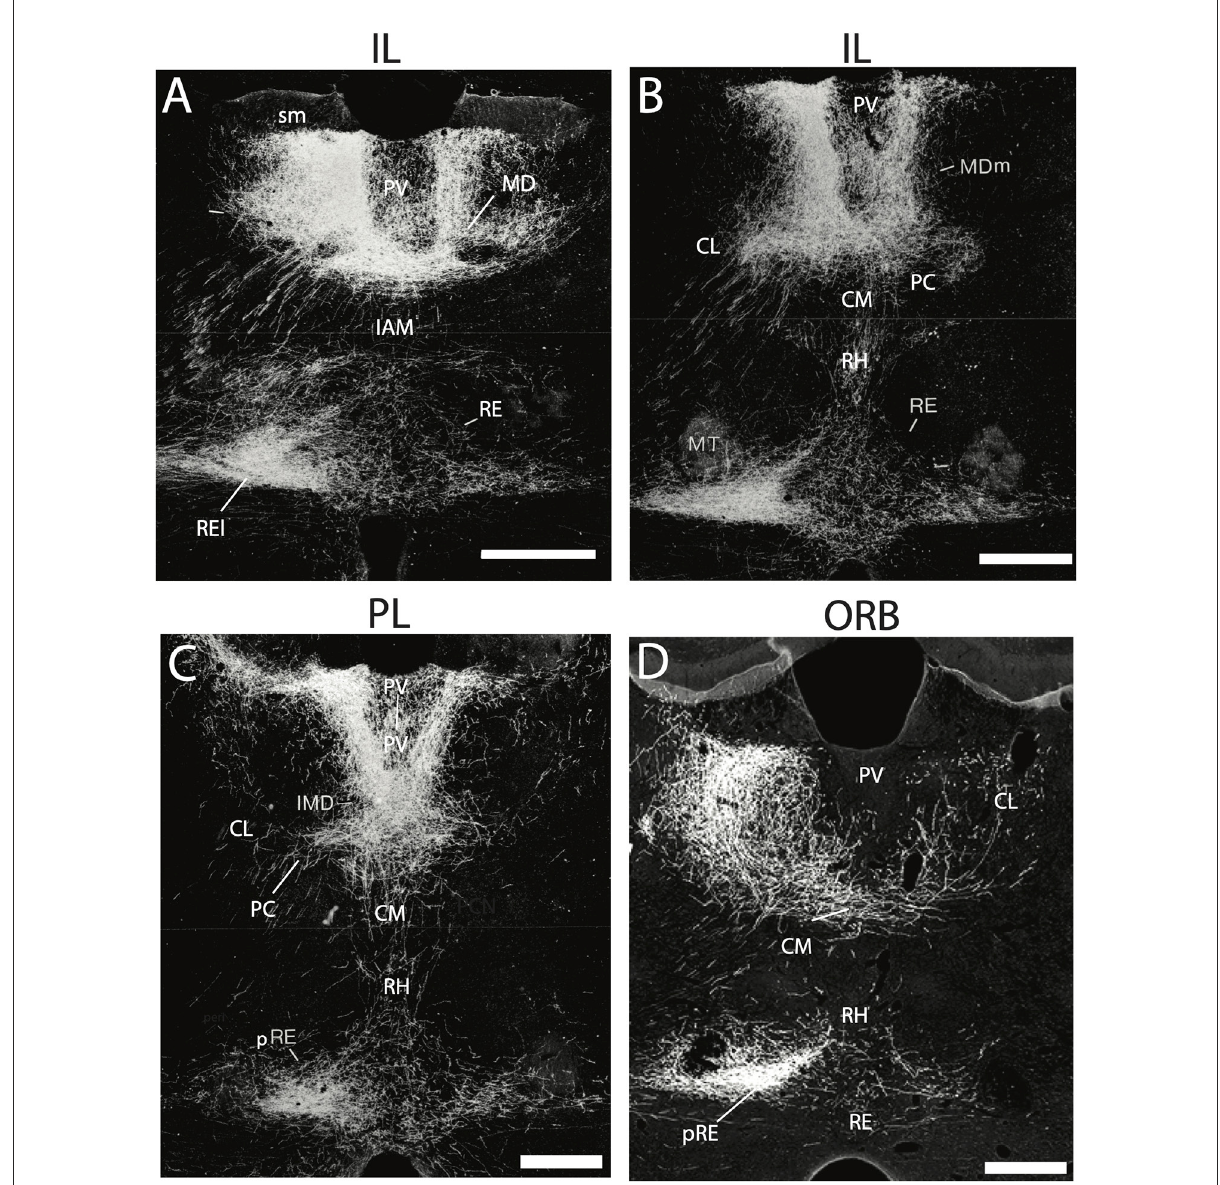
FIGURE2 (A–D) Darkfield micrographs of transverse sections through the thalamus depicting patterns of anterograde labeling produced by PHA-L injection in the infralimbic (IL) (A,B) and prelimbic (PL) (C) cortices of the medial prefrontal cortex (mPFC) and the ventral orbital cortex (ORB) (D) . As depicted, injections in IL (A,B) and PL (C) gave rise dense terminal labeling of the paraventricular nucleus (PV) and medial division of mediodorsal nucleus (MDm), dorsally and rhomboid (RH) and the nucleus reuniens (RE), ventrally, with intense labeling of the lateral wings of RE (REl), rostrally (A) and peri-reuniens (pRE), caudally (B,C) . By comparison, injections in the ventral orbital cortex (ORB) (D) produced dense labeling of the central medial (CM), paracentral (PC) and central lateral (CL) nuclei of the rostral intralaminar complex, heaviest in CL, ipsilaterally (left side) as well as pronounced labeling of the nucleus reuniens – comparable to that seen with injections in IL and PL (A–C) . IAM, interanteromedial dorsal nucleus of thalamus; IMD, interomediodorsal nucleus of thalamus; MD, mediodorsal nucleus of thalamus; MT, mammillothalamic tract; sm, stria medullaris. Scale bar for (A–D) = 450 µ m. Figure modified from Vertes (2002) and Hoover and Vertes (2011).